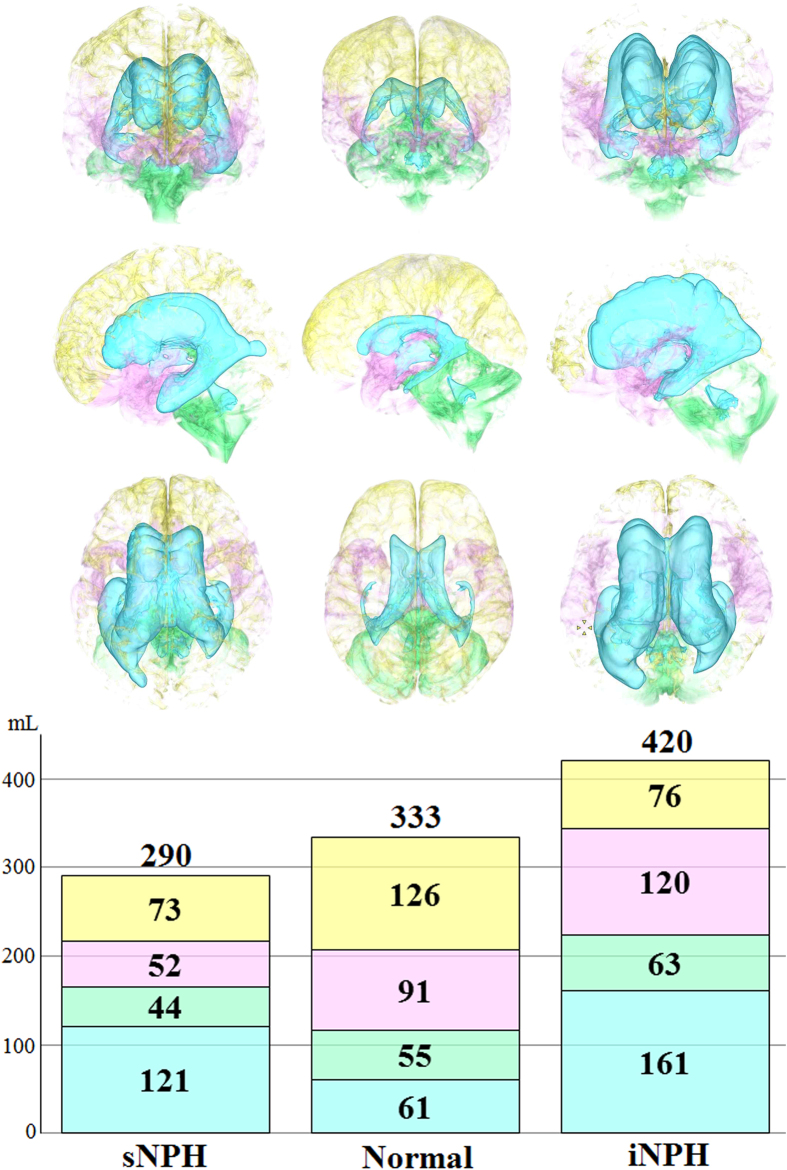
Mean volumes of the segmented intracranial cerebrospinal fluid spaces in iNPH, sNPH and normal brain.The mean volumes of ventricles (sky blue), basal cistern and Sylvian fissure (pink) and subarachnoid space in the posterior fossa (light green) were the largest in patients with iNPH. The mean volume of the convexity part of the subarachnoid space (light yellow) was equally decreased in patients with iNPH and those with sNPH.